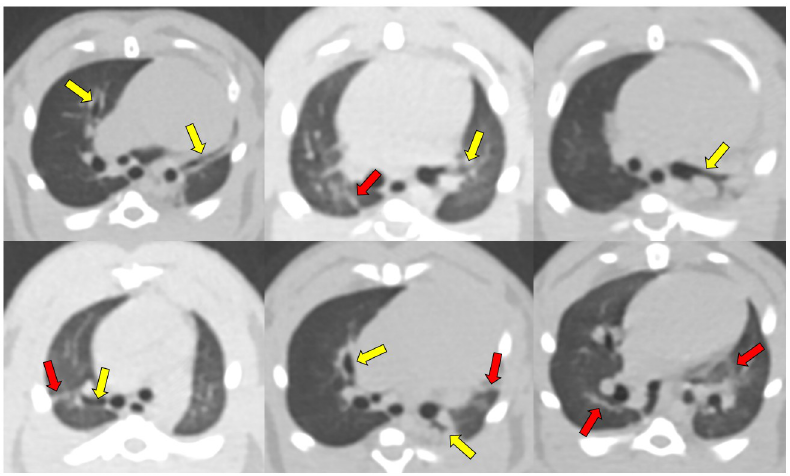
Fig 11. Representative CT images of bronchiectasis (yellow arrows) and linear densities (red arrows) correlated with lung fibrosis at 8, 26, and 52 weeks after PHMG exposure.